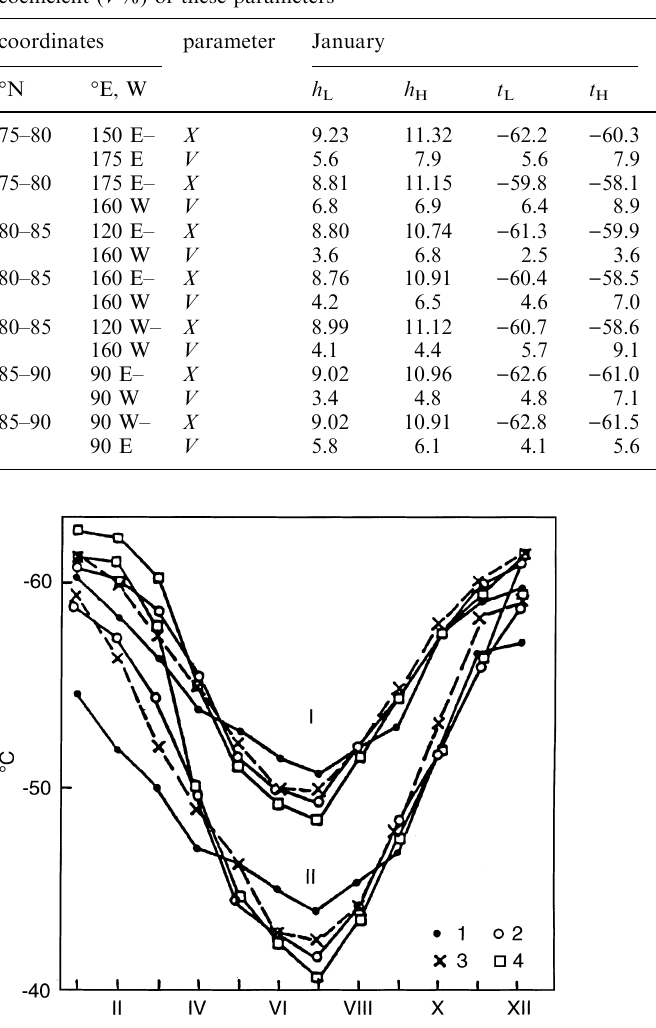
Fig. 2. Temperature of lower (I) and upper (II) bounds of tropopause over the Arctic Basin: (1) 70 (cid:176) –75 (cid:176) N; (2) 75 (cid:176) –80 (cid:176) N; (3) 80 (cid:176) –85 (cid:176) N; (4) 85 (cid:176) –90 (cid:176) N